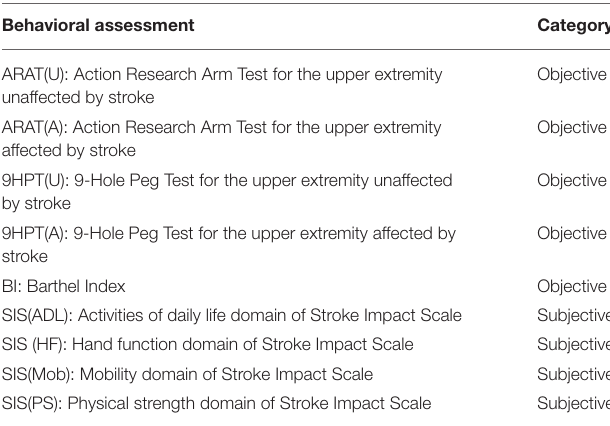
TABLE 2 | Summary of all the behavioral assessments used as